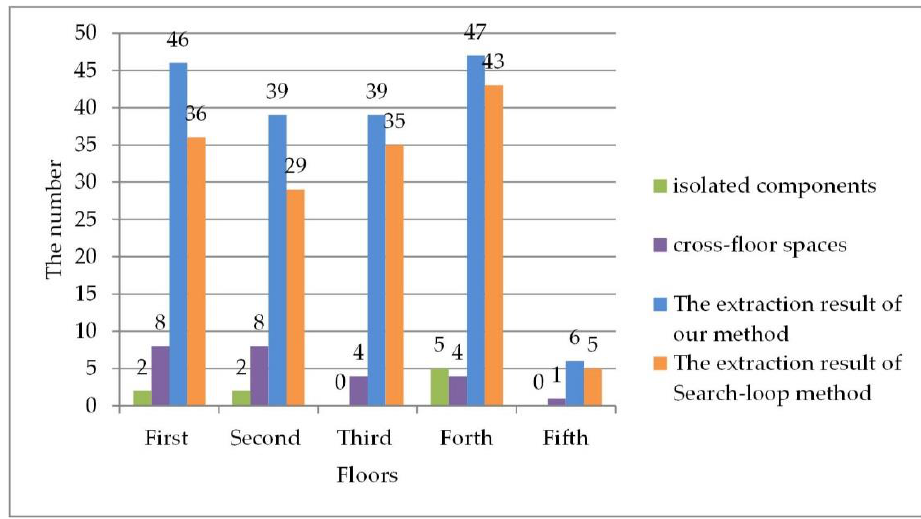
Figure 24. Comparison of the number of correct indoor spaces.